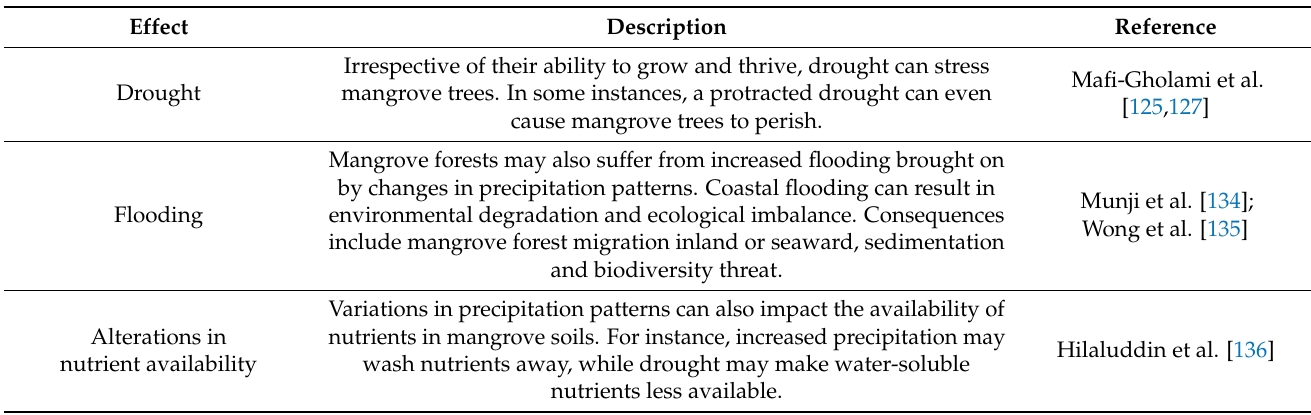
Table 11. Precipitation variability pattern on mangrove